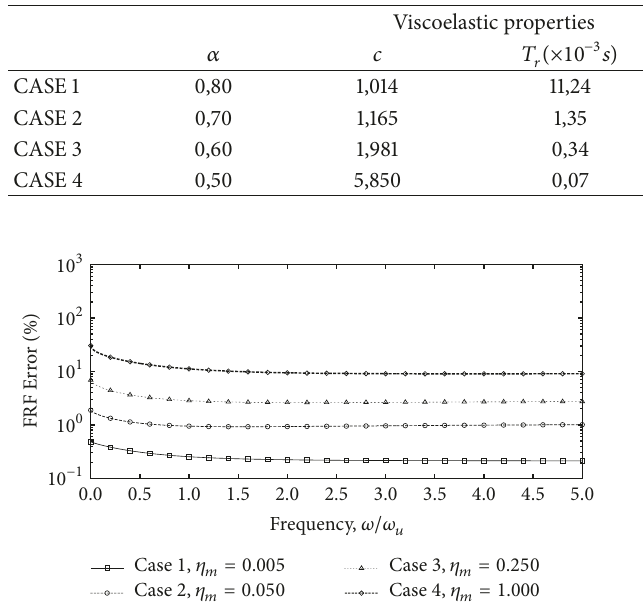
Figure 3: Example 1: single-degree-of-freedom system. Relative error (%) between frequency response functions of the viscoelastic model (exact) and the viscous approach (proposed) for the four cases shown in Table 1.